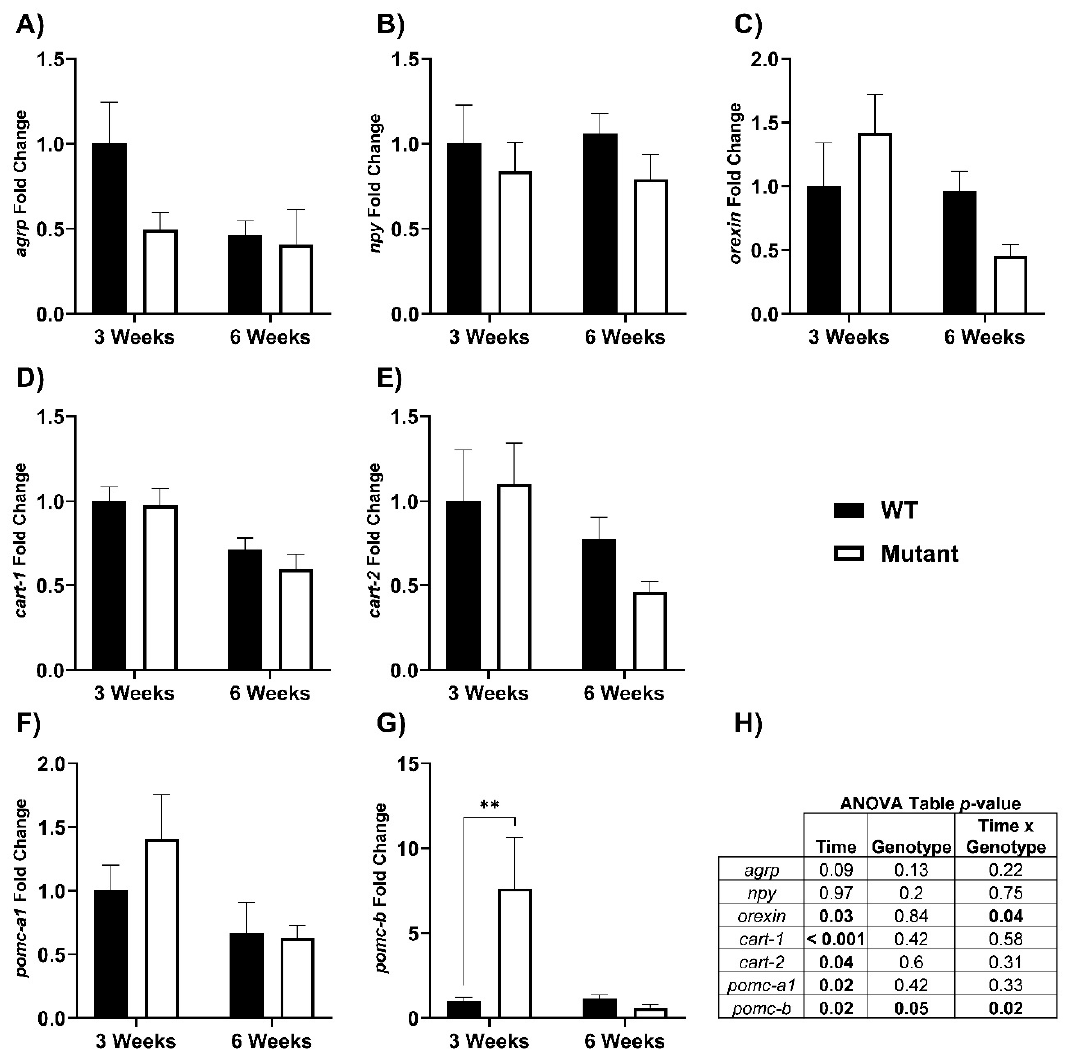
(Supplemental Figure S3: p = 0.02; WT: 1.12 ± 0.11, mutant: 0.76 ± 0.10).